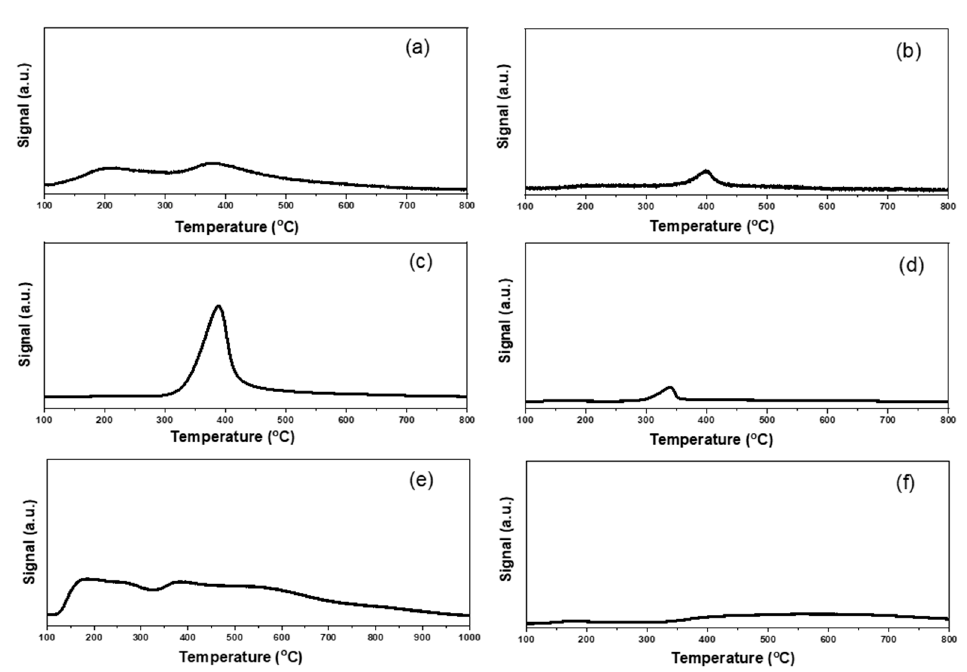
Figure 7. NH 3- TPD profiles of di ff erent supported gold catalysts: ( a ) Au 25 / ZnAl-300; ( b ) Au 25 / ZnO-300; ( c ) Au 25 / MgAl-300; ( d ) Au 25 / MgO-300; ( e ) Au 25 / Al 2 O 3 -300; ( f ) Au 25 / SiO 2 -300.